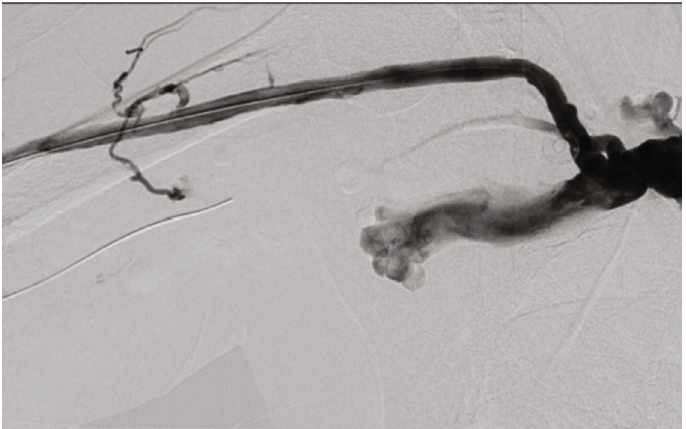
Figure 4: Out fl ow fi nal result.